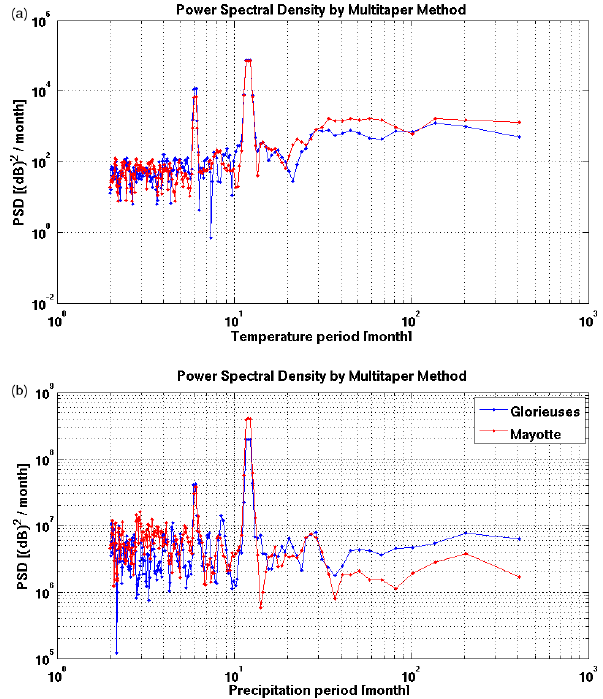
Figure 8. (a) Spectrum of temperature fluctuations ( T ) obtained at the ground from January 1966 to December 1999. (b) Spectrum of precipitation fluctuations ( P ) obtained at the ground from January 1966 to December